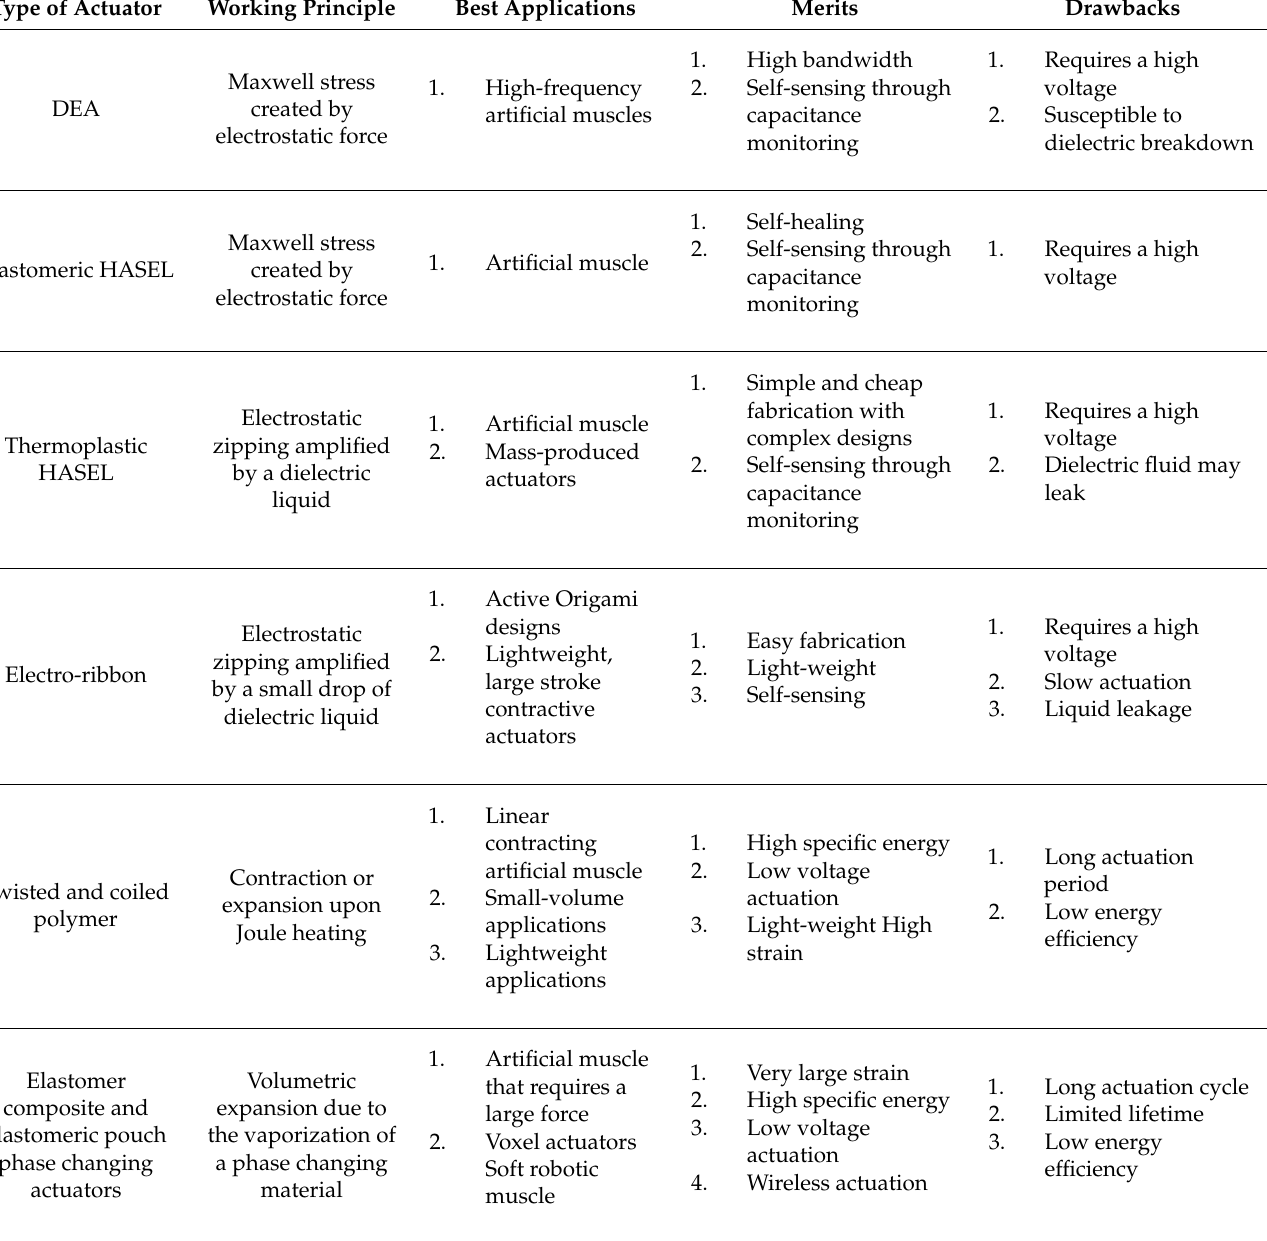
Table 1. Qualitative comparison between different types of